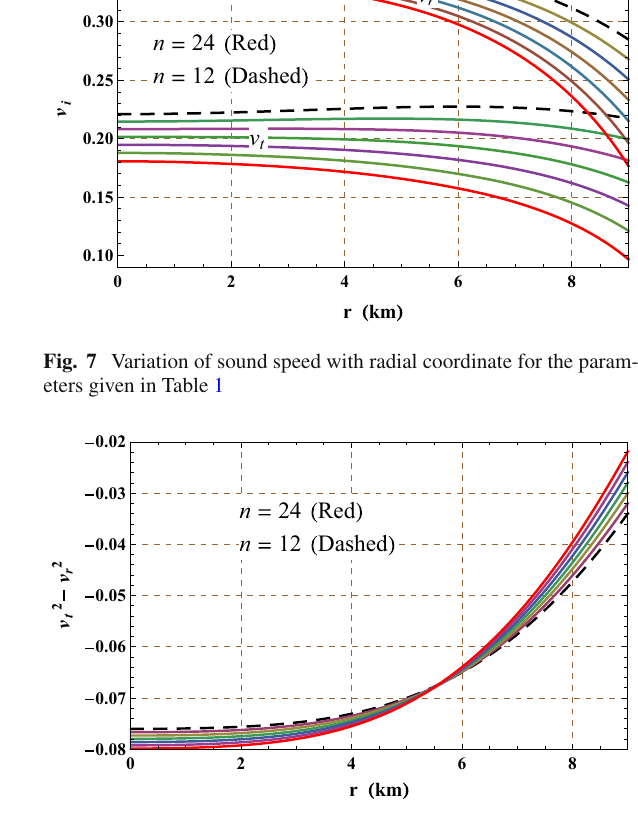
Fig. 8 Variationofstabilityfactorwithradialcoordinatefortheparam-